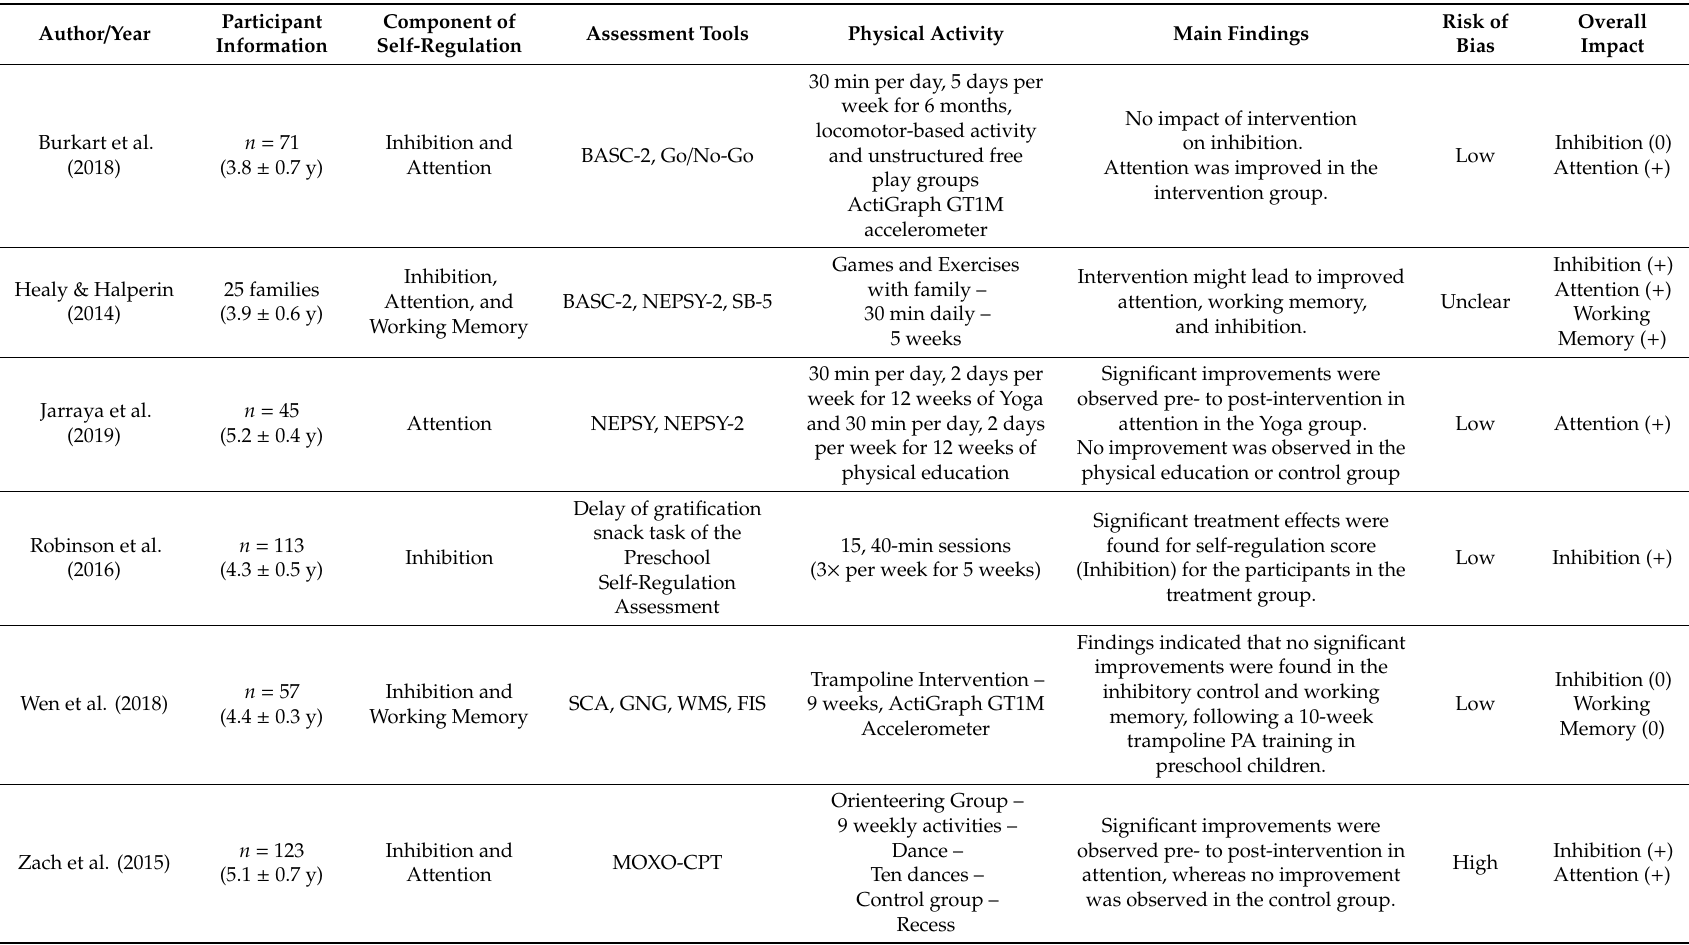
Table 1. The e ff ects of physical activity on cognitive self-regulation in preschool-aged